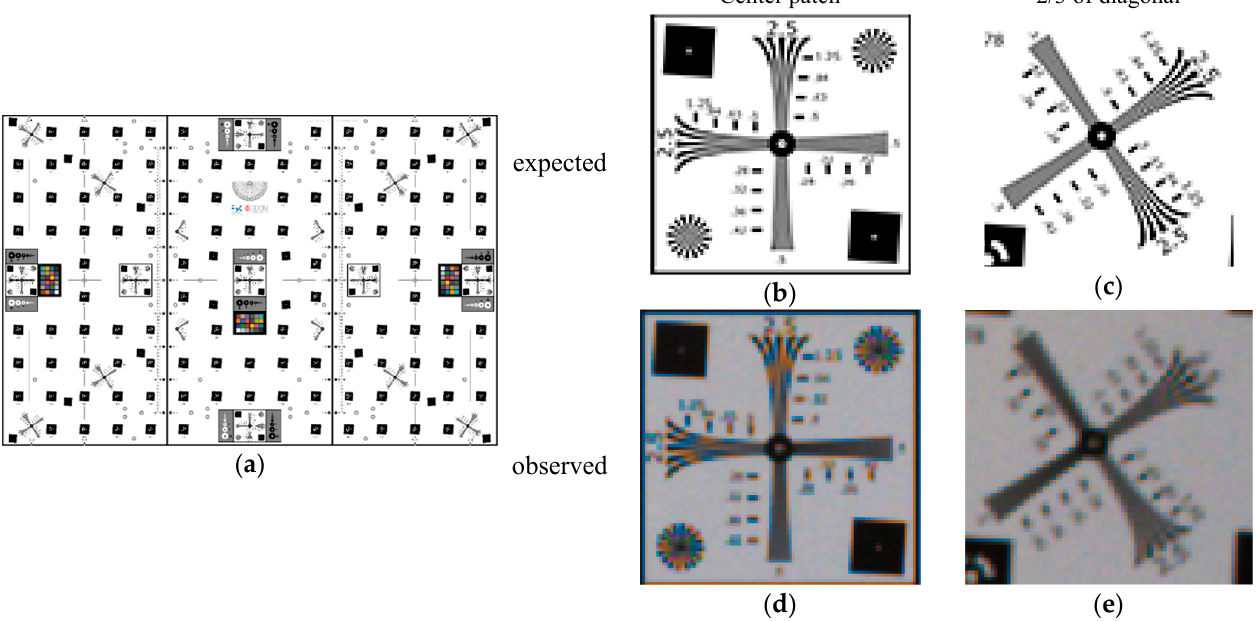
Figure 6. ( a ) Resolution chart [61] used to experimentally estimate the modulation transfer function of the used lenses. Examples of the expected resolution patches (using the designed test chart at the same resolution of 1280 pixel in width as for the camera used), respectively, at the center ( b ) and at 2/3 of the diagonal ( c ) against the imaged ones from one of the two cameras ( d , e ).